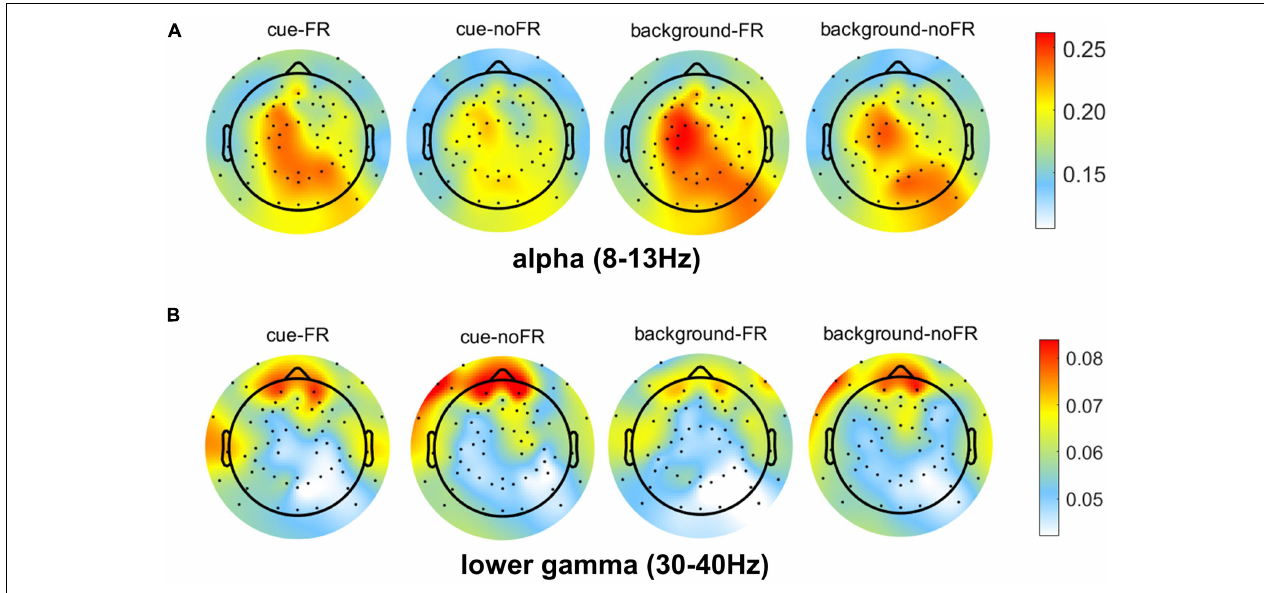
FIGURE 5 | Topographic map of RP of alpha (A) and gamma (B) bands in FR and noFR groups under cue and background conditions. Values are the group average results.